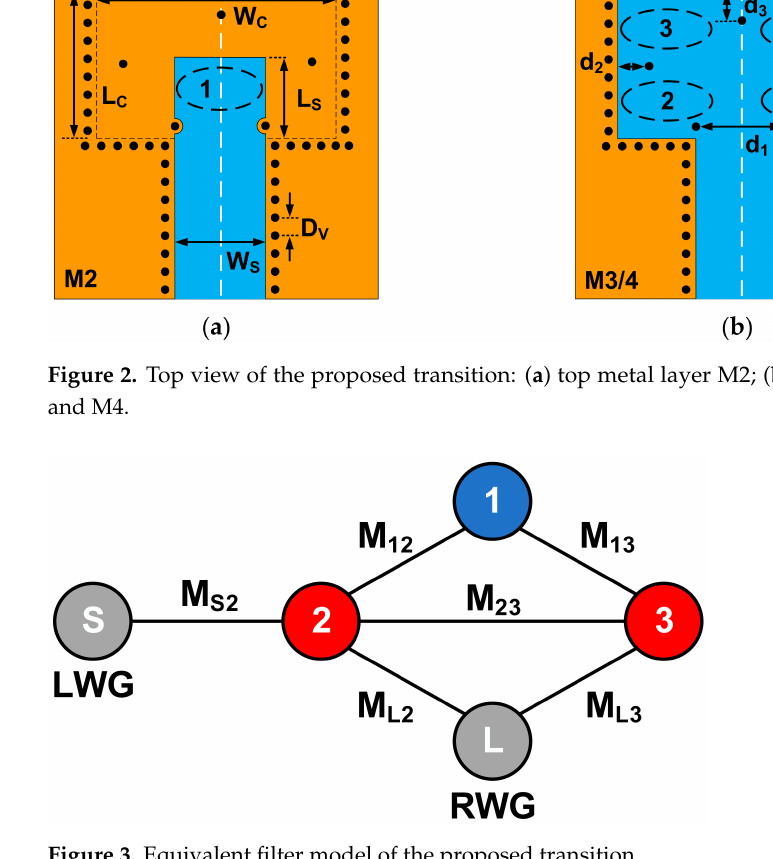
Figure 3. Equivalent filter model of the proposed